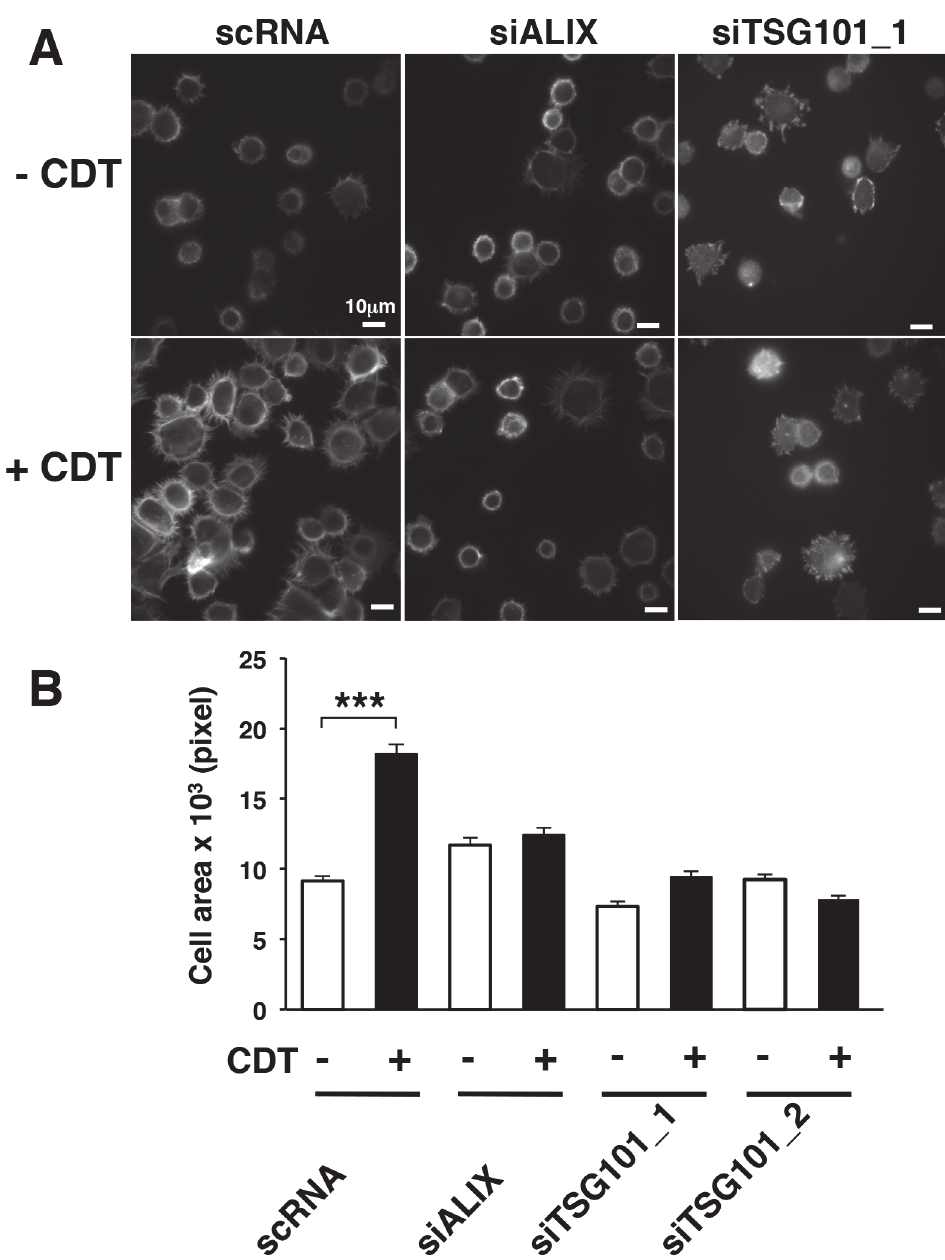
Fig 7. The ESCRT proteins TSG101 and ALIX are required to promote integrin β 1-mediated cell spreading. A. HeLa cells transfected with the non-silencing siRNA (scRNA), the ALIX or TSG101 specific siRNAs (siALIX and siTSG101) were left untreated (CTR) or intoxicated with CDT (1 μ g/ml) for 6h, prior adhesion for 20 minutes on fibronectin-coated glasses. The figure shows representative micrographs where the actin cytoskeleton was visualized by phalloidin staining. B. Quantification of the cells area was performed as described in Fig 1. The data are presented as the mean ± SEM of three independent experiments. Statistical analysis was performed using the Student t-test. *** p value <